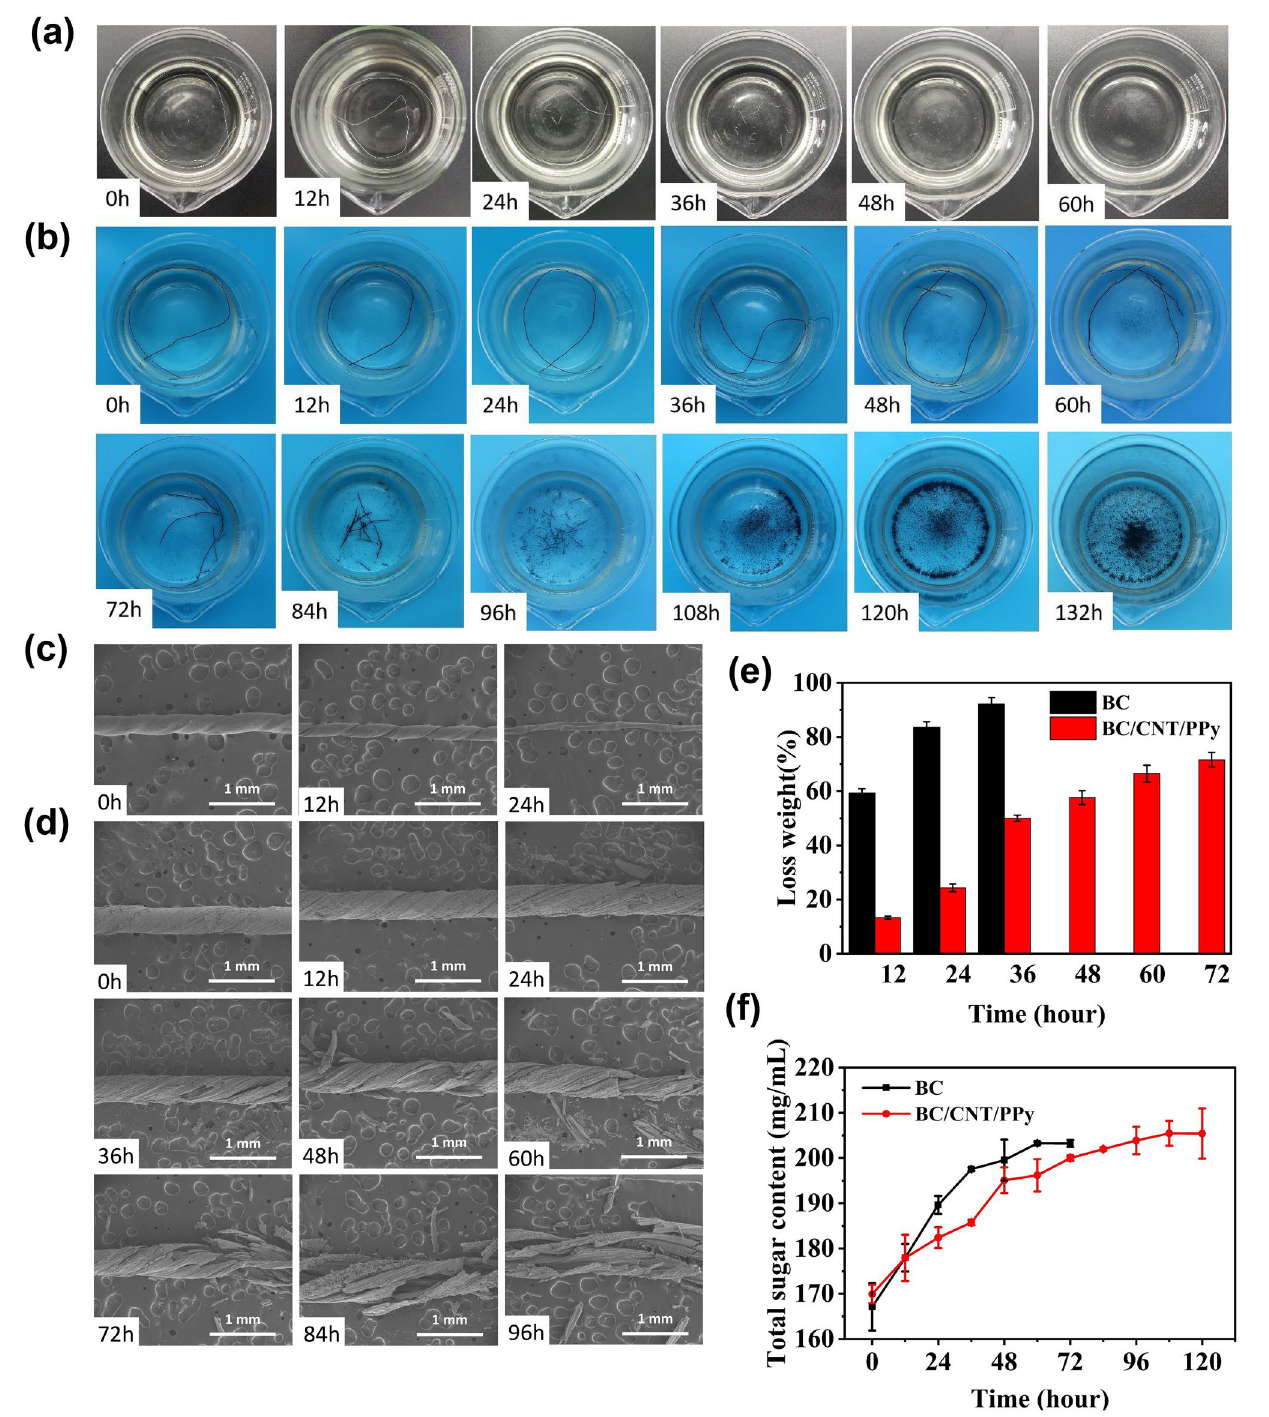
Fig. 4 The degradation experiment of BC and BC/CNT/PPy macrofiber in the cellulase solution. The photographs of macrofibers during degra- dation, a BC macrofiber, b BC/CNT/PPy macrofiber. SEM images of macrofibers, c BC macrofiber, and d BC/CNT/PPy macrofiber. e The loss weight of BC and BC/CNT/PPy macrofibers during degradation. f Total sugar content in the cellulase solution of BC and BC/CNT/PPy mac- rofibers during